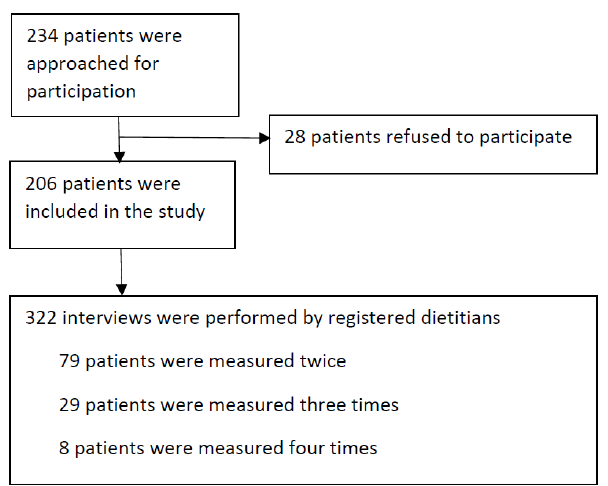
Figure 1. Flow chart of patient inclusion and measurements performed among oncology in- and outpatients aged ≥ 18 years receiving systemic anti-cancer therapy in two Dutch Hospitals between 2019–2020.